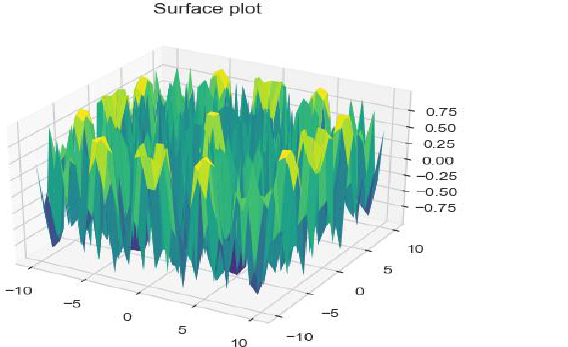
Figure 9. For function-F3 the convergence curve has shown.